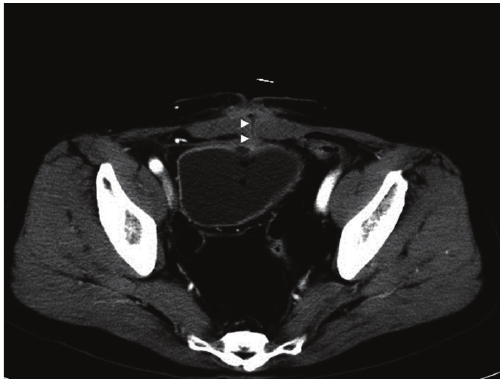
Figure 1: Images showing lower abdominal bulging with skin redness.